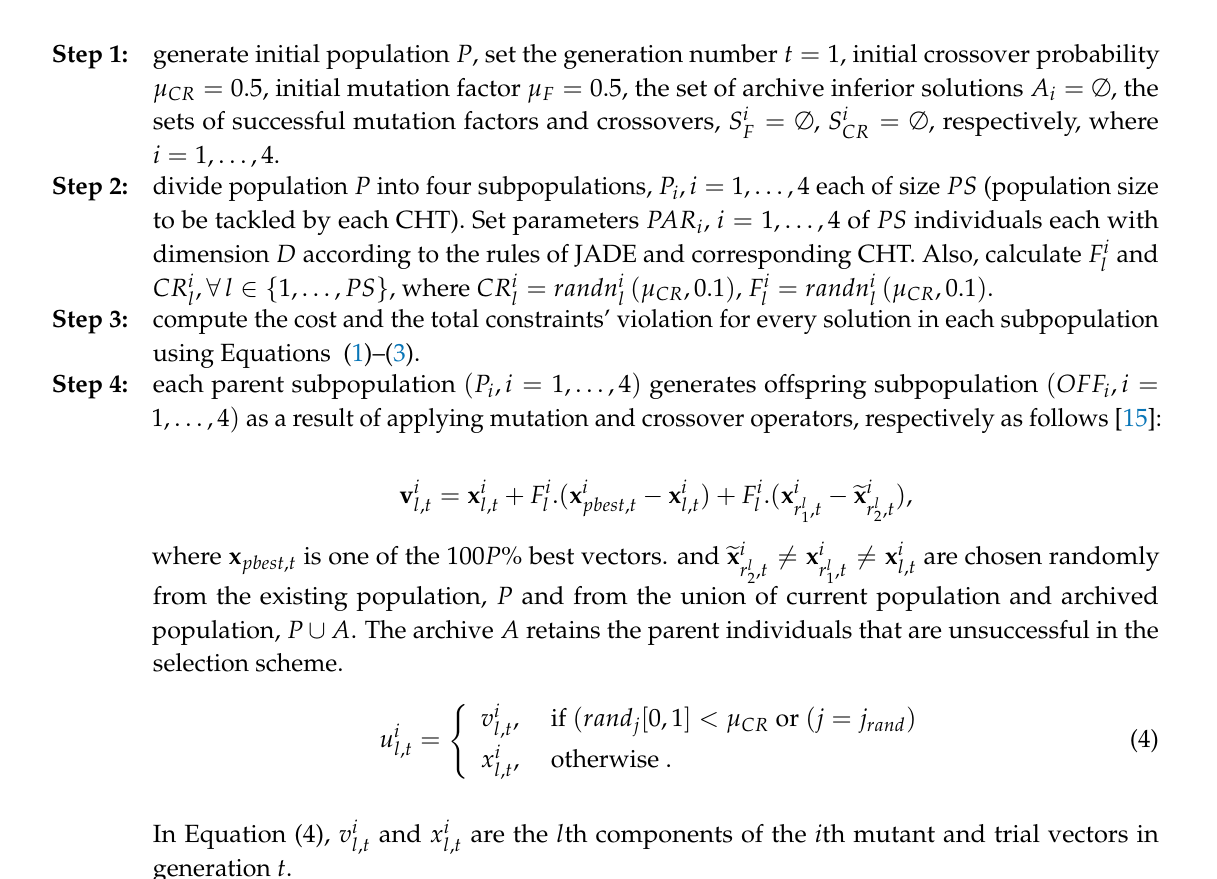
Figure 1. Flowchart of self-adaptive differential evolution with optional external archive (JADE)-ensemble of constraint handling techniques